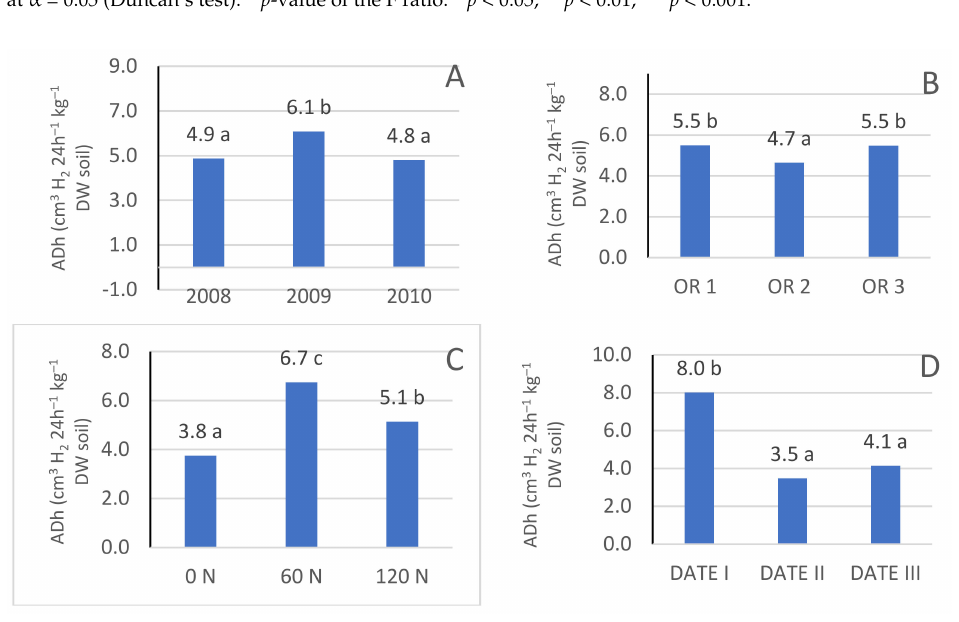
Figure 1. Dehydrogenase activity in 2008–2010. ( A )—depending on the year of conducting the re- search; ( B )—depending on the orchard; ( C )—depending on the level of fertilization; ( D )—depending on the timing of sampling.